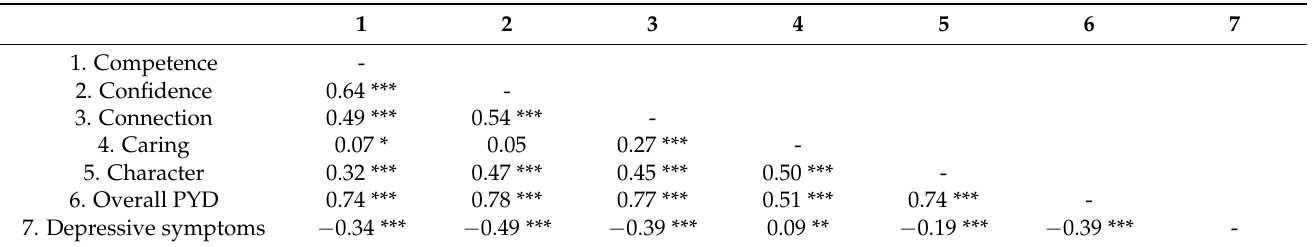
Table 3. Bivariate correlations between the 5 Cs of PYD and depressive symptoms for the total sample.